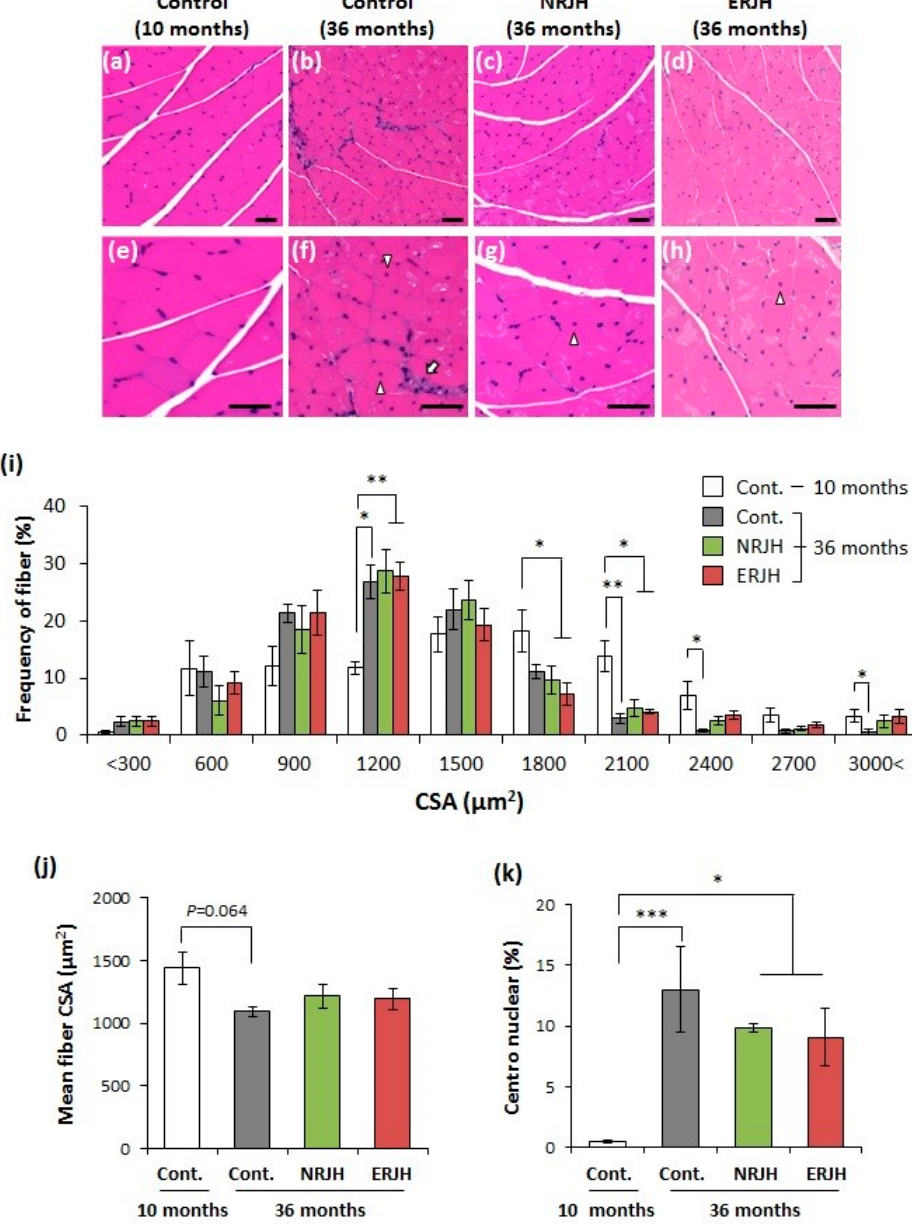
Figure 3. Effects of RJ on the age-related morphological changes in muscle fibers in genetically heterogeneous mice. A–D, Morphology of gastrocnemius muscle fibers (Hematoxylin–eosin (H & E) staining) of young ( a , e ), aged ( b , f ), aged NRJ-treated ( c , g ), and aged ERJ-treated ( d , h ) mice. The upper panels show a low magnification ( a – d ), and the lower panels show a high magnification ( e , f ). Fibers with centronuclei were observed in aged mice (see arrowheads in the figure). Inflammatory cell infiltration is indicated by the white arrow. The bar indicates 100 µ m. ( i ), Distribution of the cross-sectional areas (CSA) of gastrocnemius muscle fibers. ** P < 0.01, * P < 0.05. ( j ), The mean fiber CSA was calculated from the average CSA of over 170 fibers in individual mice. Data are shown as the mean ± SEM ( n = 5–8). ( k ), percentage of the muscle fiber with centronuclei. Data are shown as the mean ± SEM ( n = 5–8). P values were determined by the Kruskal–Wallis test (post-hoc Dunn’s multiple comparisons test). *** P < 0.001, ** P < 0.01, * P <